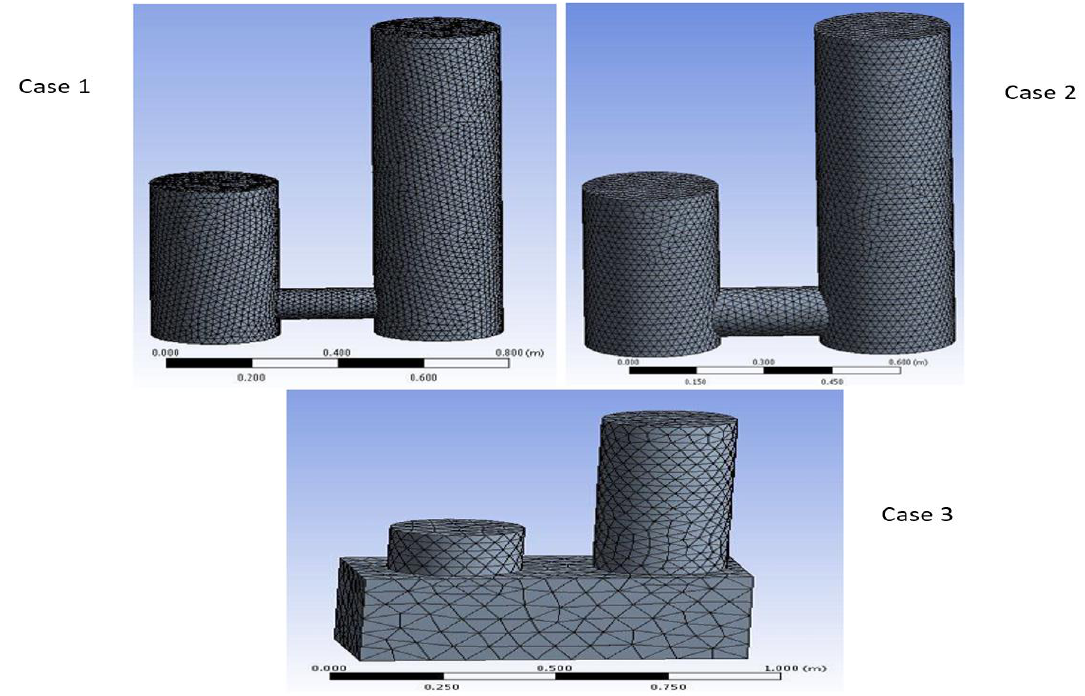
Figure 2. Wall mesh arrangement using tetrahedral configurations used in ANSYS v9 (Case 1, existing 4” pipe; Case 2, new 6” connection; Case 3, box design).